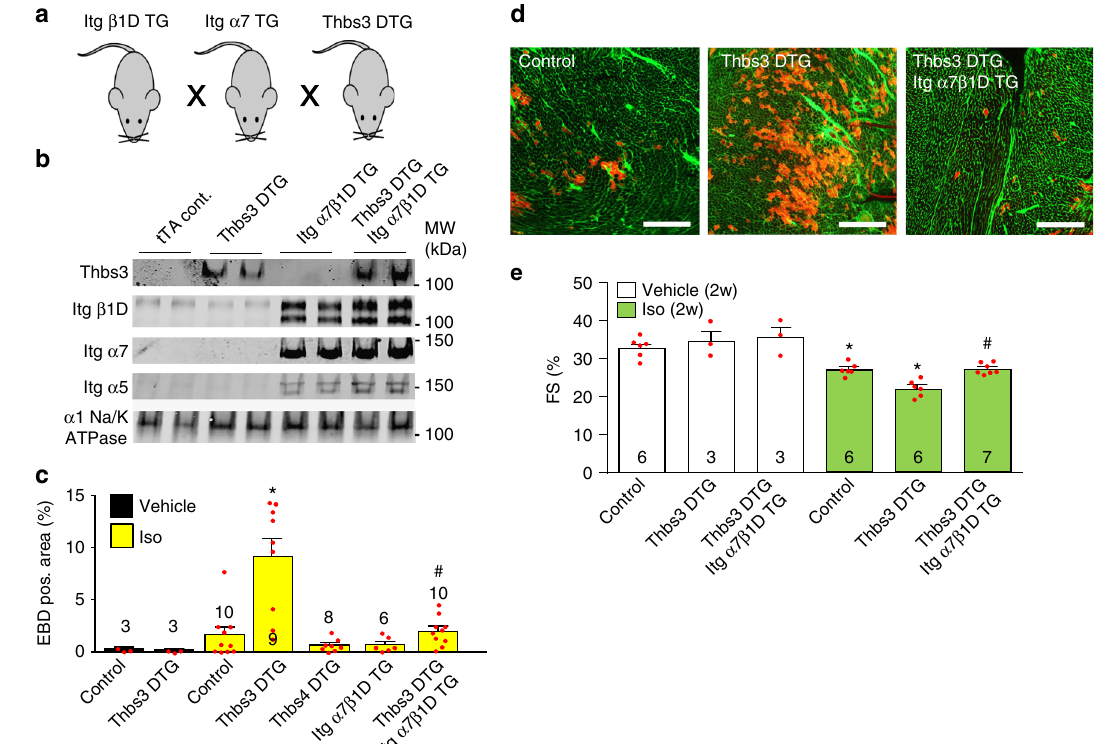
Fig. 6 Integrin overexpression reduces Thbs3-mediated membrane instability and disease. a Schematic of the breeding used to generate combinatorial Thbs3 DTG, α 7 β 1D integrin TG mice. b Representative Western blots for Thbs3 and the indicated integrin proteins from heart sarcolemma protein extracts from tTA, Thbs3 DTG, α 7 β 1D integrin TG and Thbs3 DTG/ α 7 β 1D integrin TG mice. The α 1Na + /K + -ATPase served as loading control. c Quanti fi cation